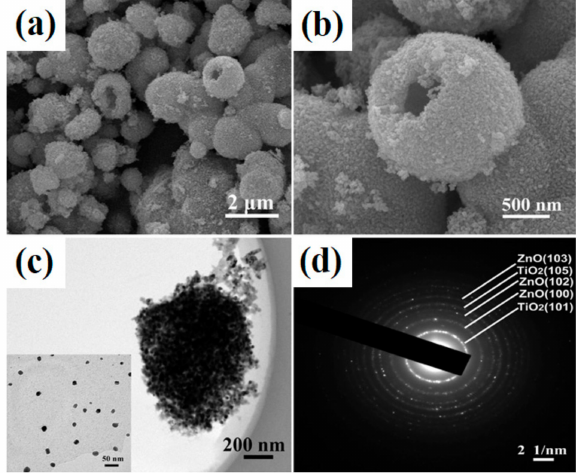
Figure 2. ( a , b ) SEM; ( c ) high-resolution transmission electron microscopy (HRTEM) and ( d ) selected area electron diffraction (SAED) images of the TiO 2 -ZnO system (created based on [61] with permission from Elsevier